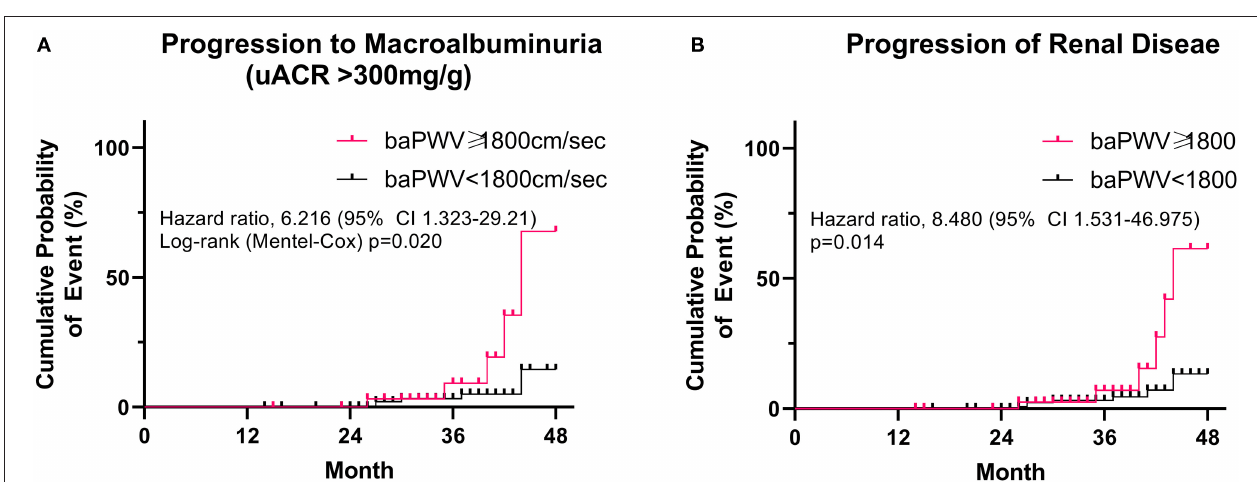
FIGURE 2 | Risk of peripheral arterial stiffness (baPWV ≥ 1800 cm/s) on (A) progression to macroalbuminuria (uACR > 300mg) and (B) progression of renal disease. A log-rank (Mantel-Cox) survival analysis was